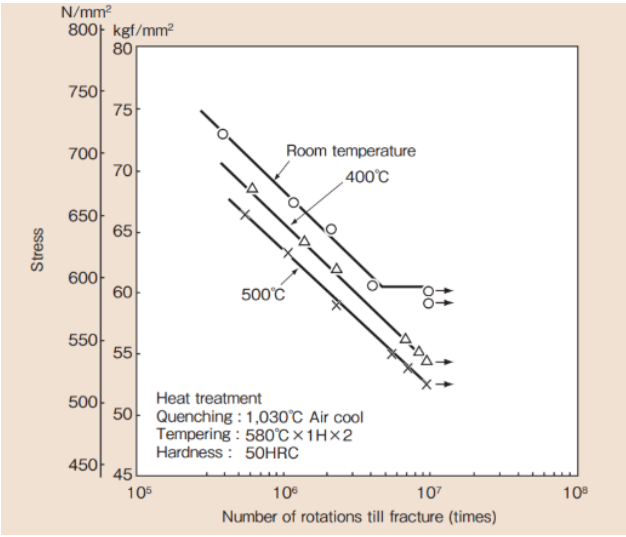
Figure 18. The S–N Curve obtained through the rotational bending fatigue test of the SKD 61-based material—the maximum stress of 400 MPa on the spring due to the stopper was lower than the fatigue limit of the SKD 61 material.